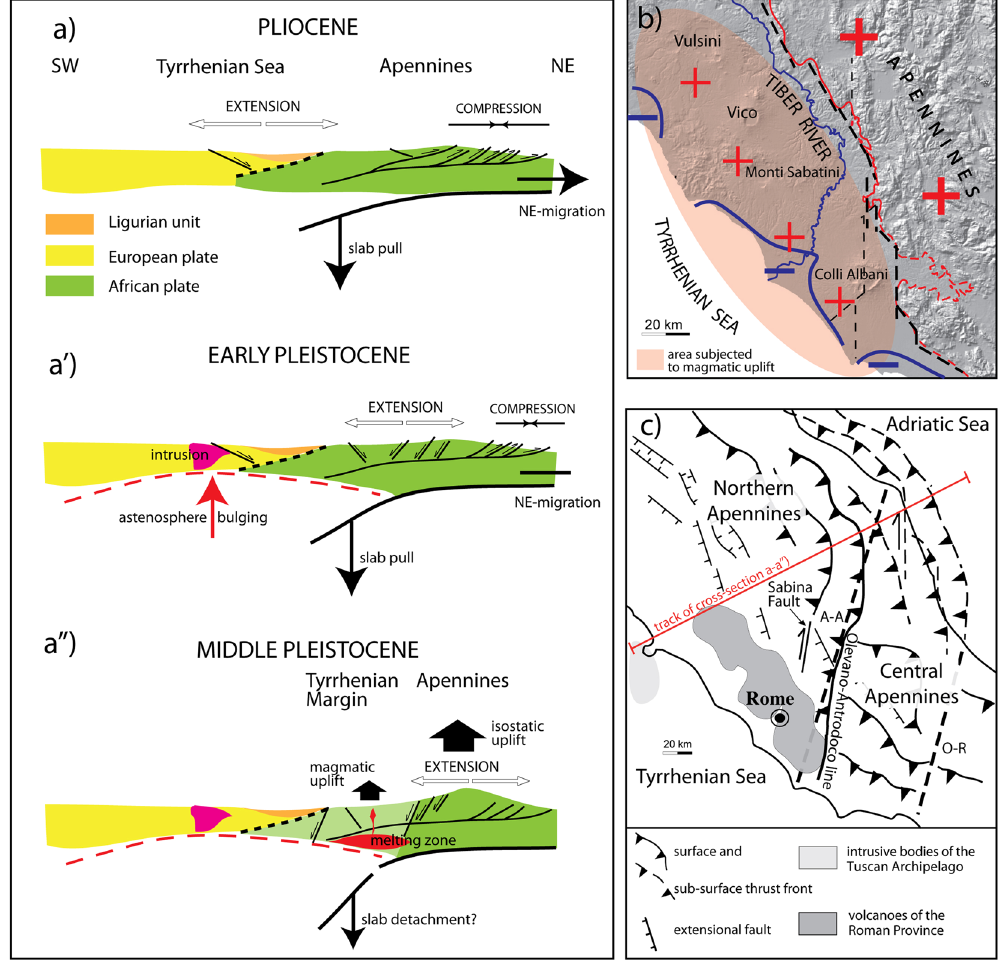
Figure 2. Cross-section showing the geodynamic elements responsible for the evolution of the Tyrrhenian Sea margin of Italy 3 during Pliocene ( a ′ ) and Pleistocene ( b – b ′ ) times. ( b ) Map view showing the different components of the regional uplift; DEM modified after TINITALY/01 square WA 6570, used with permission of the Istituto Nazionale di Geofisica e Vulcanologia, Rome. ( c ) Structural scheme of central Italy; map hand drawn with Adobe© Illustrator CS3 13.0.0 graphic program. See text for